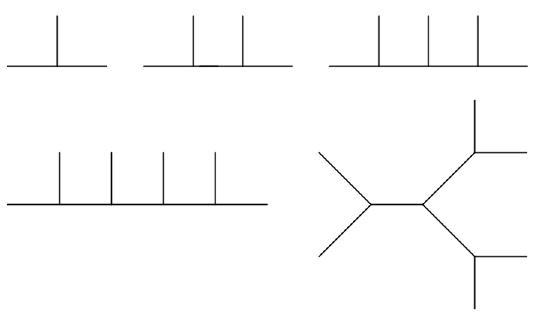
Figure 1. The trivalent diagrams relevant at lower-point scattering; all have half-ladder topology at three-, four- and five-points, while at six-points there are half-ladder and snow-flake